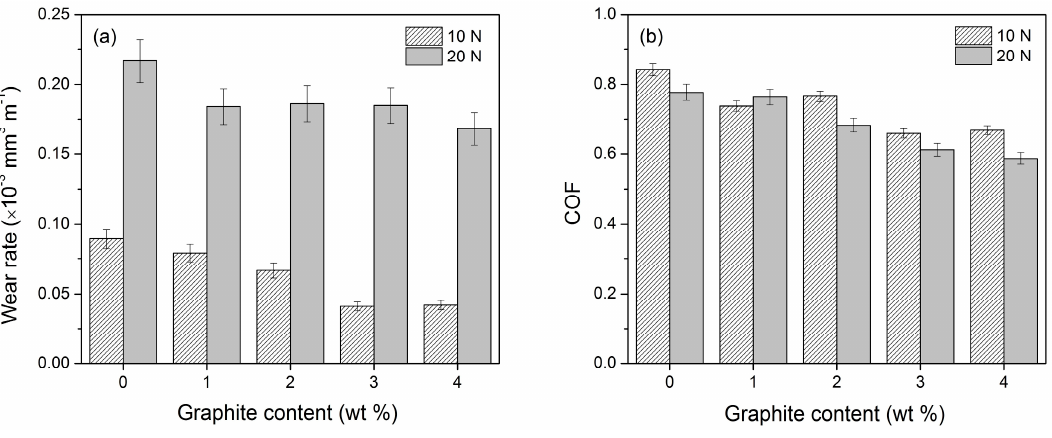
Figure 3. ( a ) Average wear rate; ( b ) coefficient of friction ( COF) of the BMG and BMG/graphite composites.